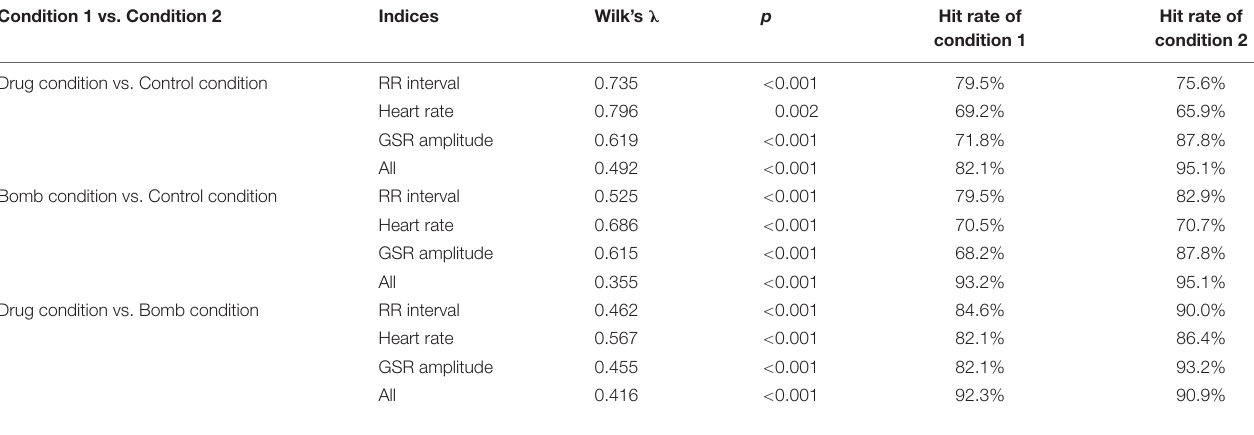
TABLE 3 | Hit rates (i.e., correct classification rates) of participants in every two of three conditions, using one of three and all physiological indices in Experiment 2. Condition 1 vs. Condition